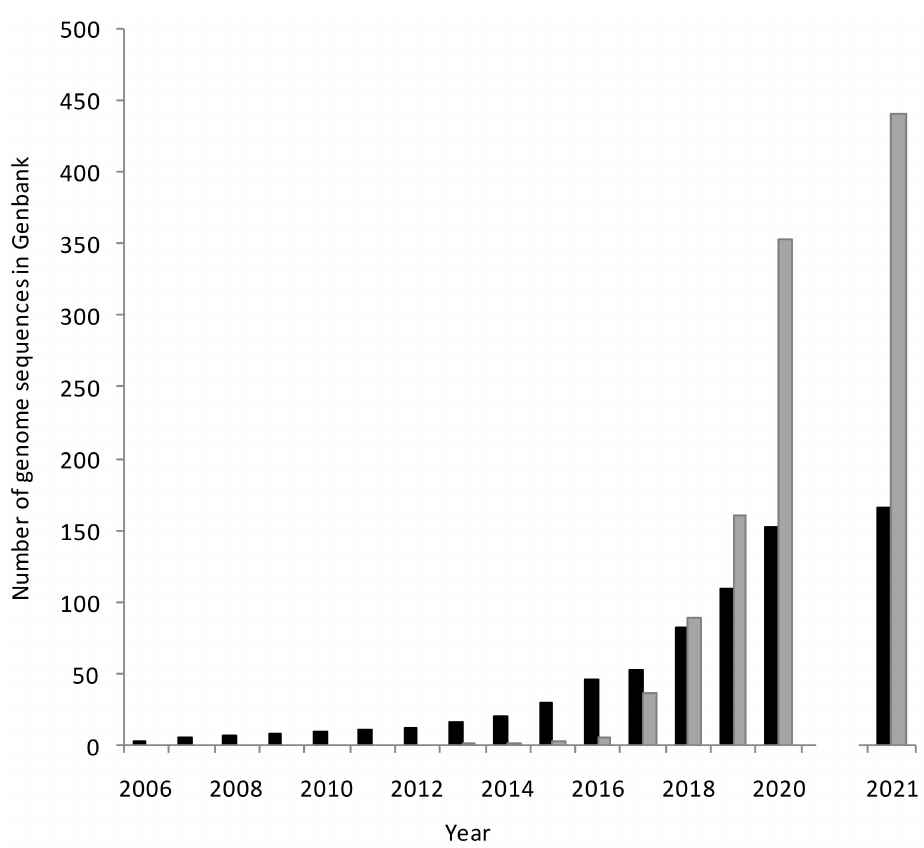
Figure 1. An exponential increase in myxobacterial genome sequencing. The numbers of genome sequences from cultured strains (black columns) and MAGs (grey columns) available at the end of each year are shown. The columns for 2021 only include genomes and MAGs published in the first six months of the